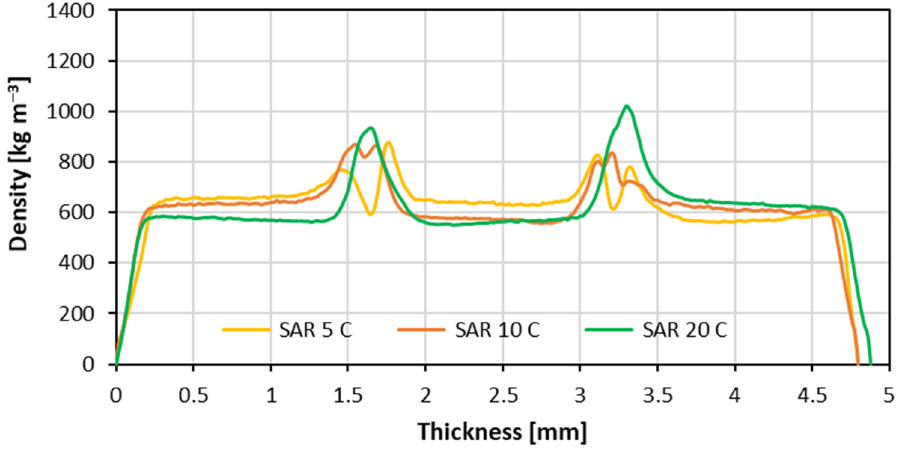
Figure 10. The density profiles of the plywood samples of different SAR filler content, cold-pressed.